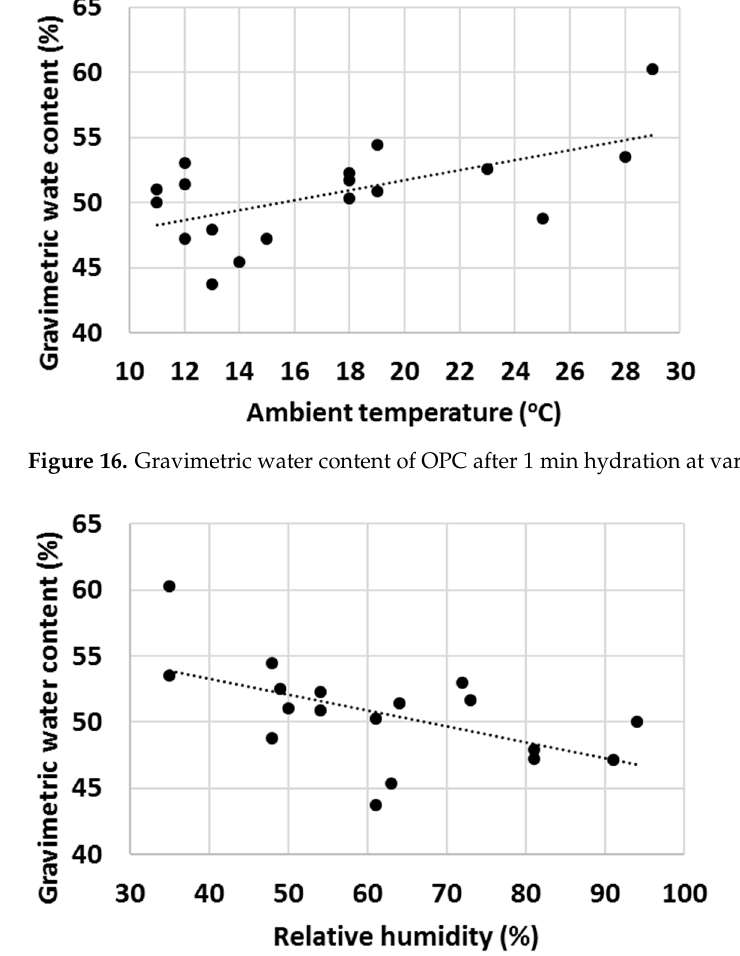
Figure 18. Changes in relative humidity with ambient temperature.